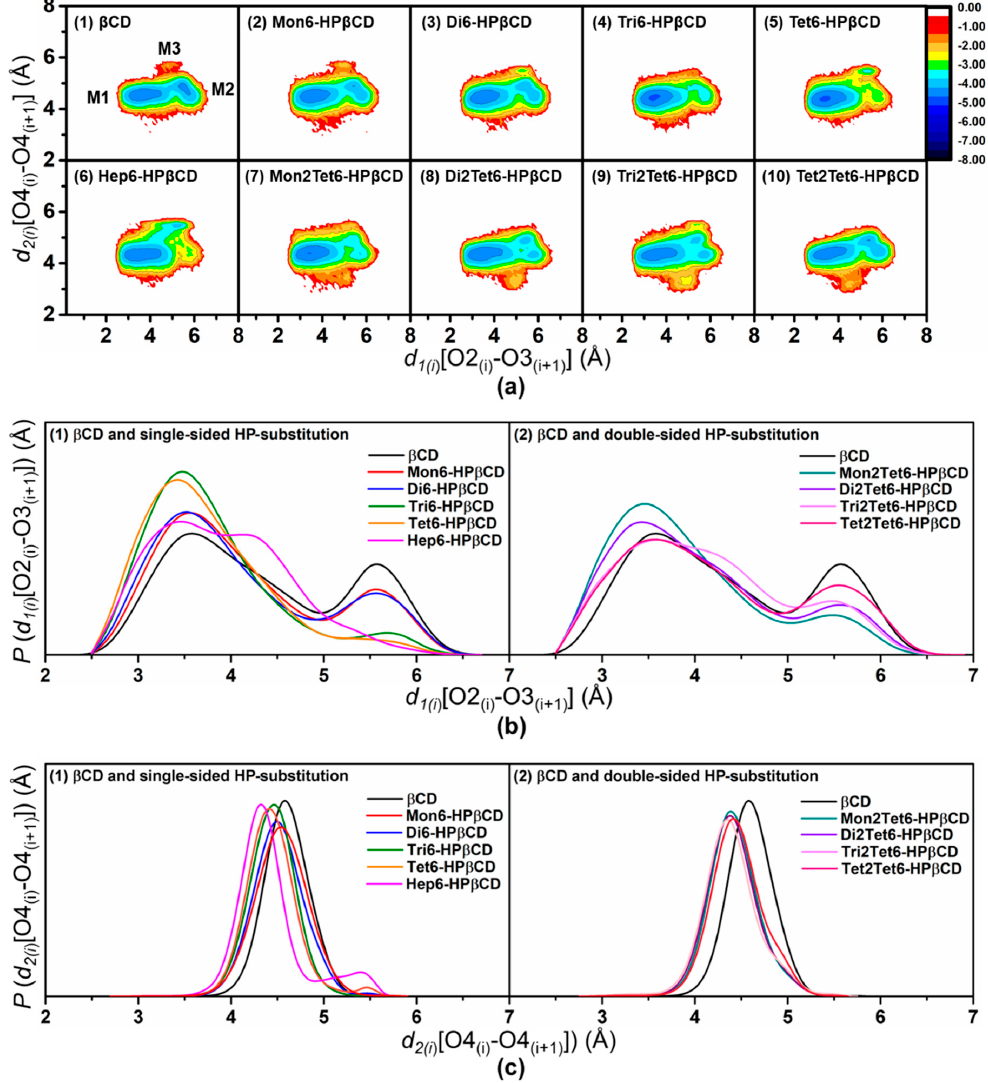
Figure 4. ( a ) Contour graphs of the probability distributions in terms of free energy, ( b ) the probability of d 1(i) , and ( c ) the probability of d 2(i) from a total of 25,000 snapshots at 300 K of REMD simulations with the glycam06 force field for β CD and HP β CDs.